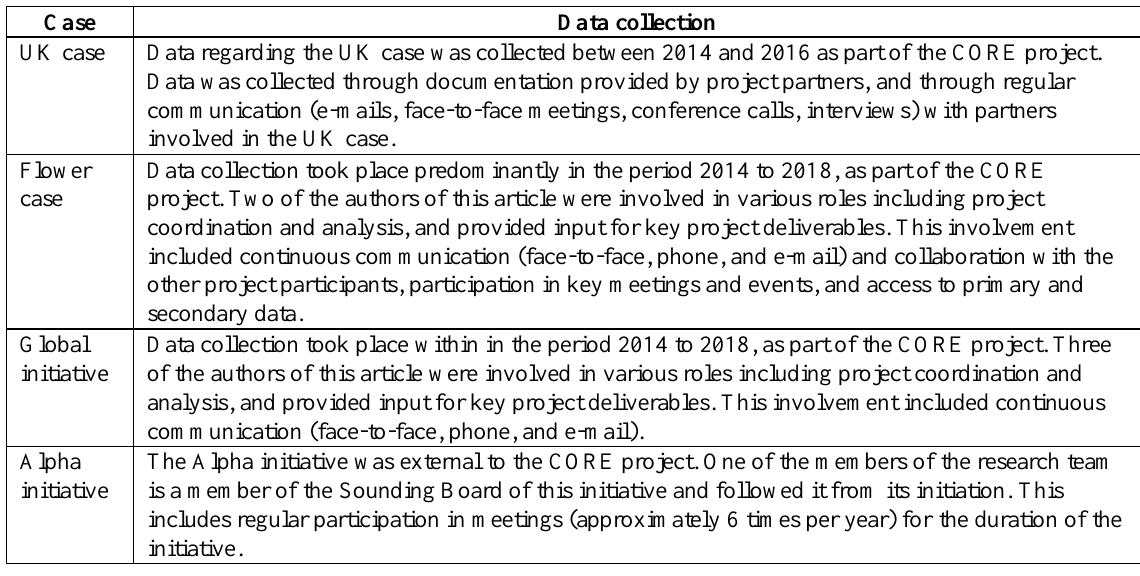
Table 1. Data collection for the four